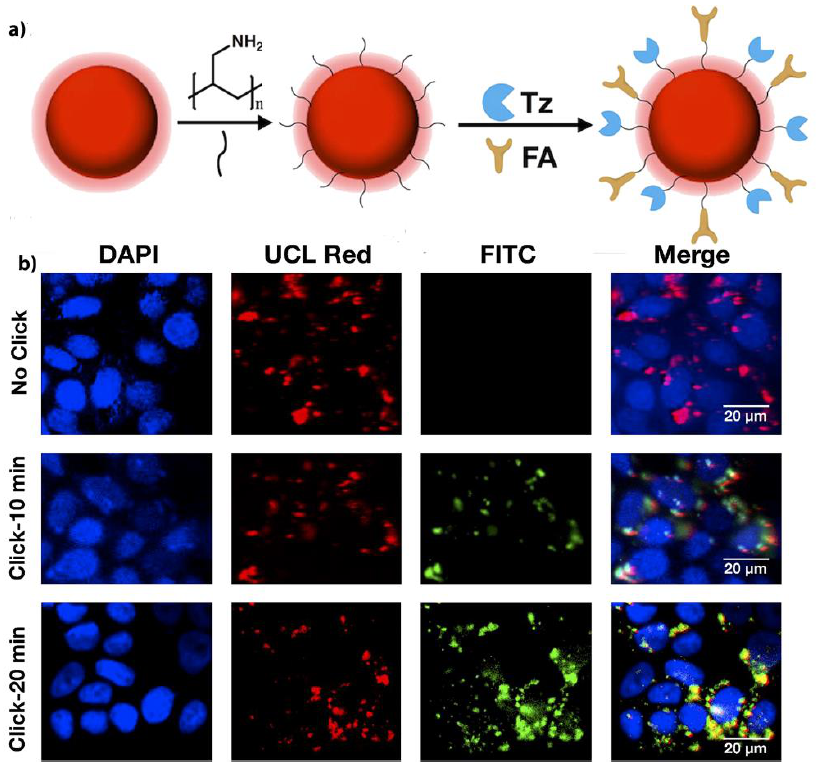
Figure 12. ( a ) Schematic synthesis of UCNPs-Tz/FA-PEG, ( b ) MCF-7 cells treated with UCNPs- Tz/FA-PEG or UCNPs-FA-PEG for UCL imaging with 980 nm light excitation (red channel), and click reaction with FITC-NB (green channel), and stained with DAPI (blue channel). Top: control (no click), middle: click for 10 min and bottom: click for 20 min. Reprinted with permission from reference [156] . Copyright 2019 Elsevier.